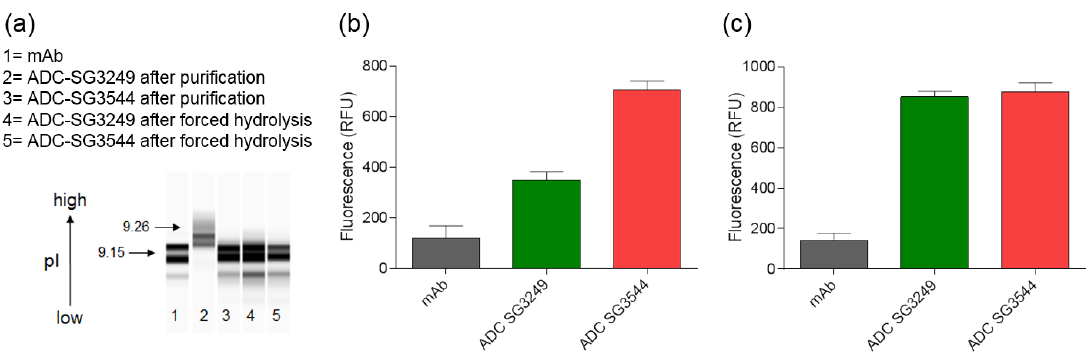
Figure 3. Evaluation of thiosuccinimide hydrolysis by capillary isoelectric focusing (CIEF) measurement and SYPRO Orange fluorescence. ( a ) CIEF analysis of monoclonal antibody (mAb) and antibody-drug conjugates (ADCs) before and after thiosuccinimide hydrolysis; ( b ) Fluorescence intensity of mAb and ADCs upon incubation with SYPRO Orange dye; and, ( c ) Fluorescence intensity of mAb and ADCs upon incubation with SYPRO Orange dye after thiosuccinimide hydrolysis. Thiosuccinimide hydrolysis was achieved by incubation at 37 °C, pH 7.8, three days for samples in ( a , c ). Thiosuccinimide hydrolysis was also evaluated using a SYPRO Orange dye binding